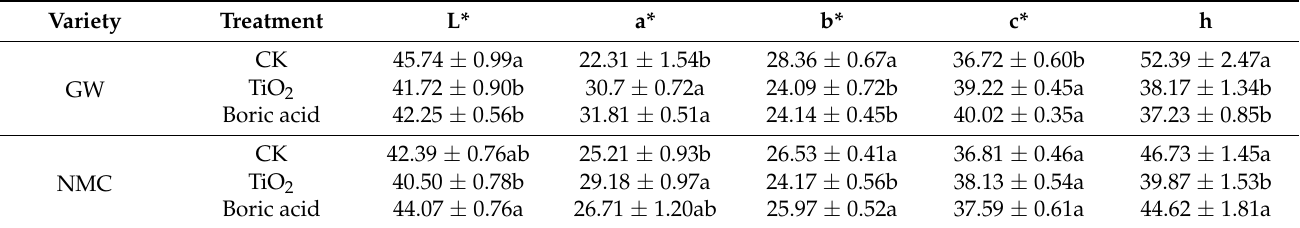
Table 2. ‘Guiwei’ and ‘Nuomici’ maturity peel color after the pollination